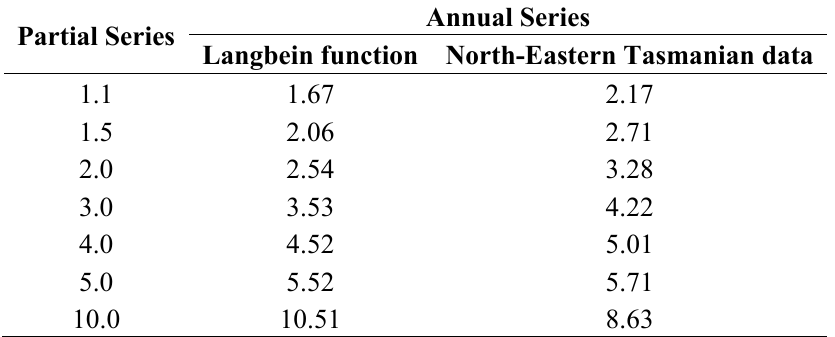
Table 4. Annual series average recurrence intervals (in years) equivalent to partial series as predicted by Langbein’s function and estimated from mean values across 13 North-Eastern Tasmanian stream-flow